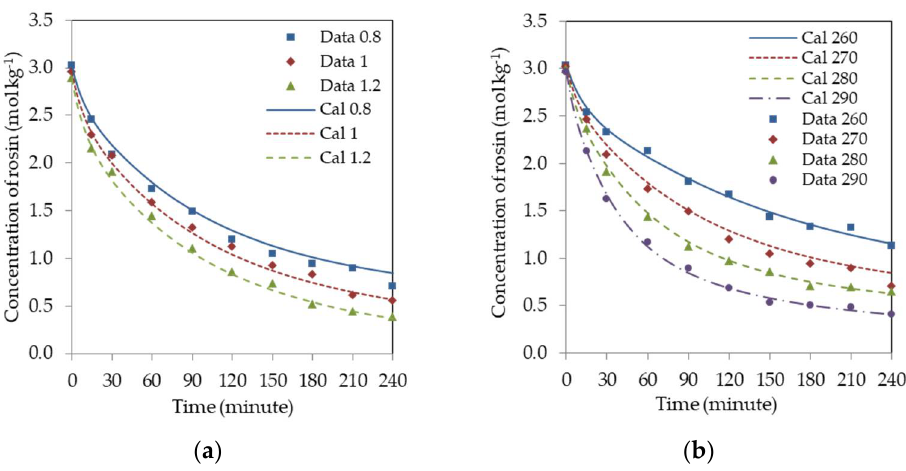
Figure 5. The concentration of rosin during the reaction ( a ) at 270 °C and several initial ratios of pentaerythritol to rosin ( b ) at several temperatures with the initial ratio of 0.8.